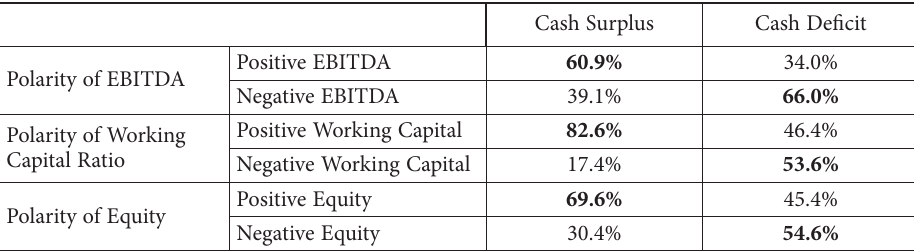
Table 6. Relative polarity frequencies of cash liquidity to other indicators (source: author based on Bisnode MagnusWeb)